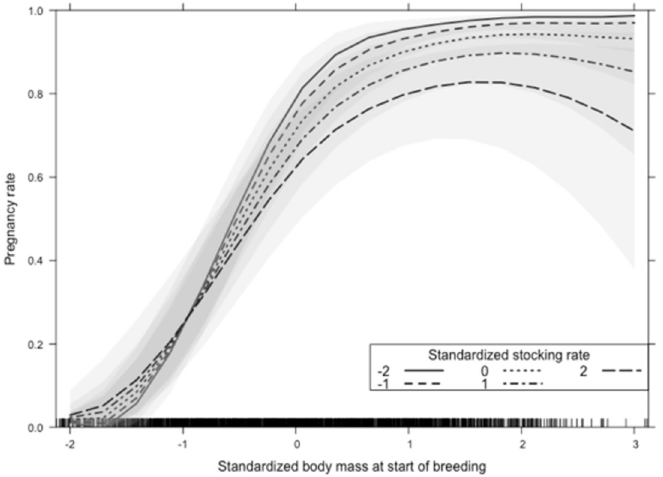
Fig 3. Interaction between body weight at the beginning of the breeding season and stocking rate on pregnancy rate of heifers and primiparous cows. Shaded areas are 95% confidence intervals. Tickmarks above the horizontal axis represent observations.